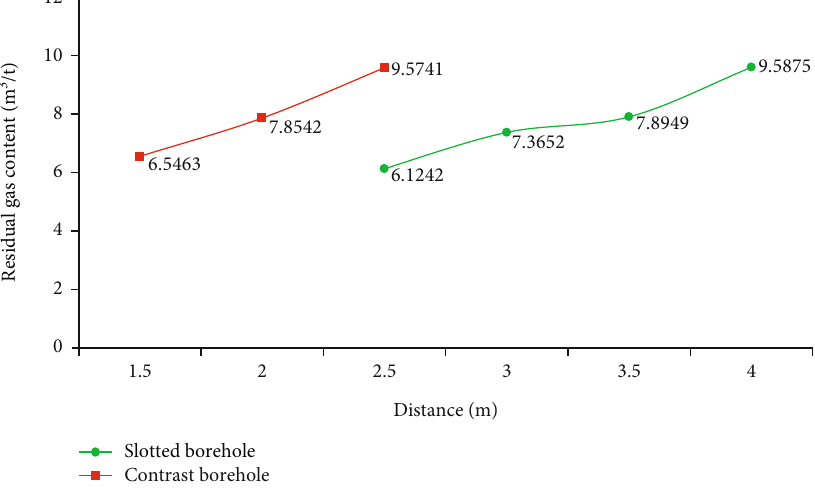
Figure 26: Determination results of residual gas content after 3 months of